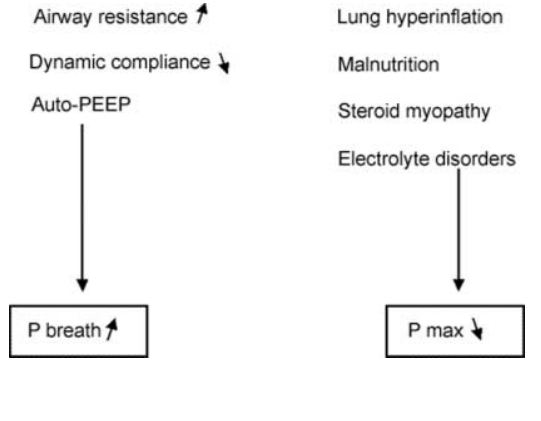
Mechanisms leading to an imbalance between respiratory muscle load (P breath ) and capacity (P max ) in